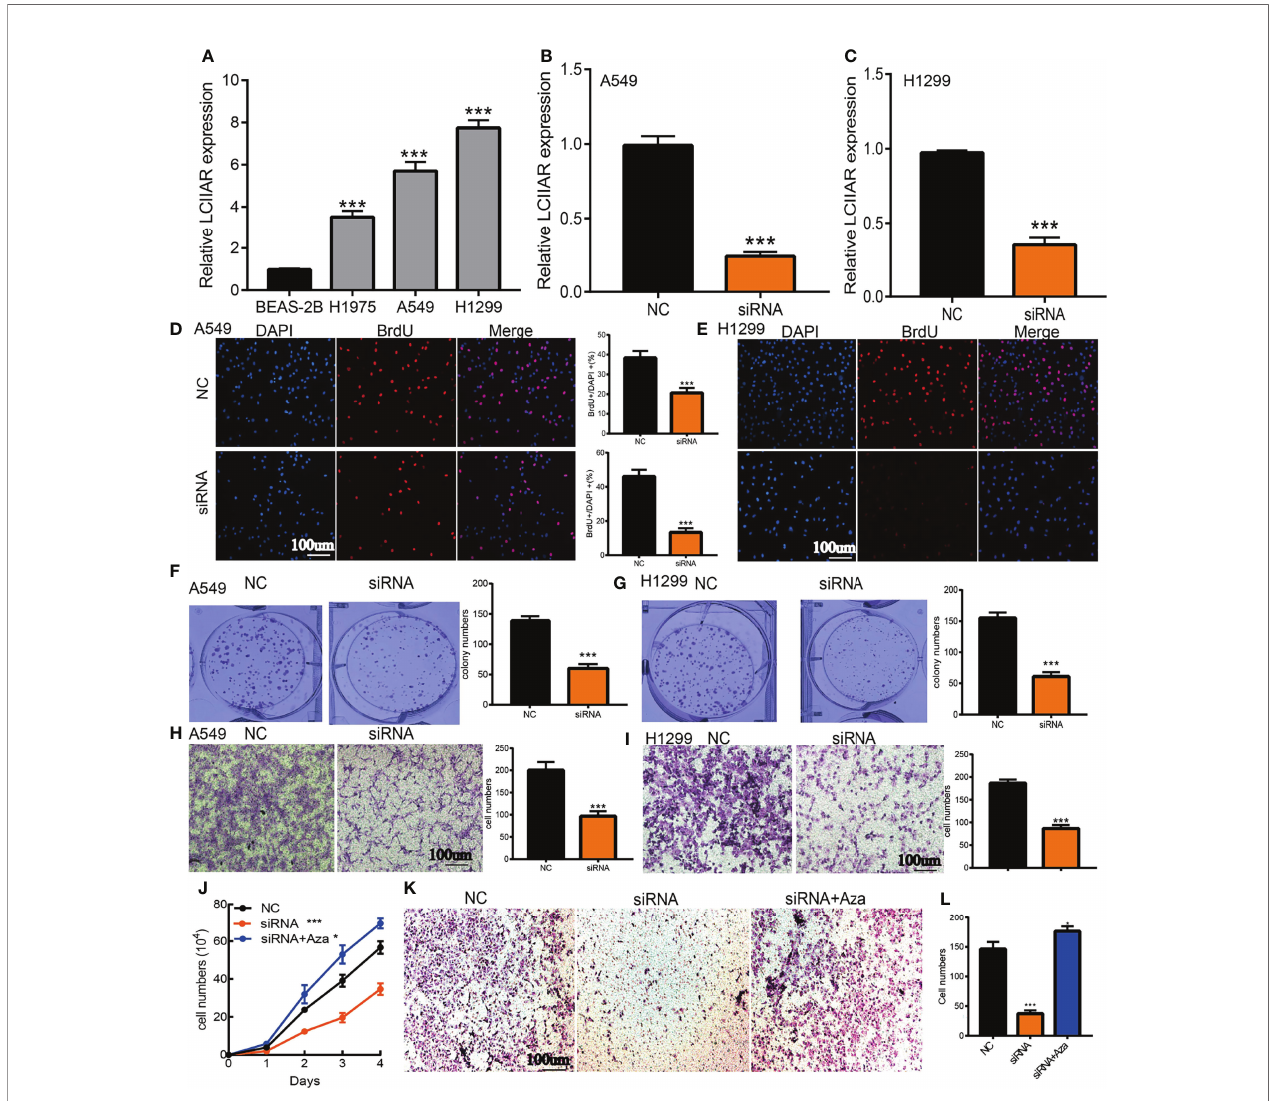
FIGURE 8 | Depletion of LCIIAR inhibited the proliferation and cell migration of LUAD (A) The expression level of LCIIAR in LUAD cells lines and BEAS-2B. (B, C) Establishment of LCIIAR knockdown cell lines in A549 and H1299 veri fi ed by Real-time RT-PCR (D – G) Knockdown of LCIIAR signi fi cantly inhibited cell growth examined by BrdU and colony formation assays. (H, I) Knockdown of LCIIAR inhibited LUAD cells migration determined by transwell assays. (J-L) Assessment of the role of hypo-methilation in LCIIAR-mediated lung cancer proliferation and migration, scale bar=100 m m, NC=negative control, siRNA=LCIIAR siRNA *p < 0.05, ***p <